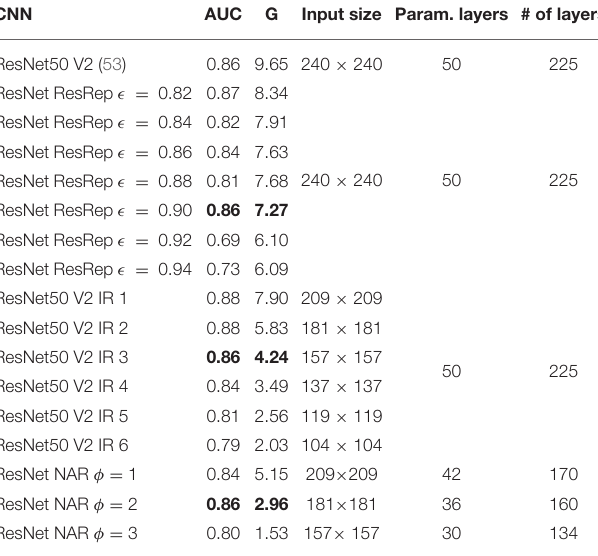
TABLE 3 | AUC, Giga- (G) correspondent to model input size, number of parameter layers, and total of model layers of ResNet50 V2 and simplified networks by ResRep, IR, and